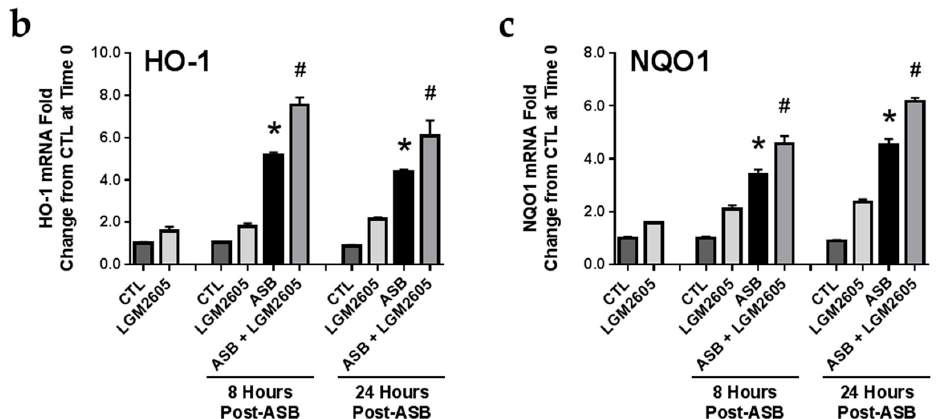
Figure 6. LGM2605 Boosts Nrf2 Activation and the Expression of Antioxidant Enzymes in Elicited Murine Peritoneal Macrophages. ( a ) Levels of active, nuclear Nrf2 were determined at 0, 1, 2, 4, 6, 8, and 12-h post asbestos exposure; Macrophage mRNA expression of ( b ) HO-1 and ( c ) NQO1 was determined at 0, 8, and 24-h post asbestos exposure using qPCR. Levels of target gene mRNA were normalized to β -actin RNA and values are expressed as fold change from CTL. Data are presented as mean ± SEM. * indicates a statistically significant difference ( p < 0.05) between ASB and CTL treated cells; # indicates a statistically significant difference ( p < 0.05) between ASB and ASB + LGM2605 treated cells.